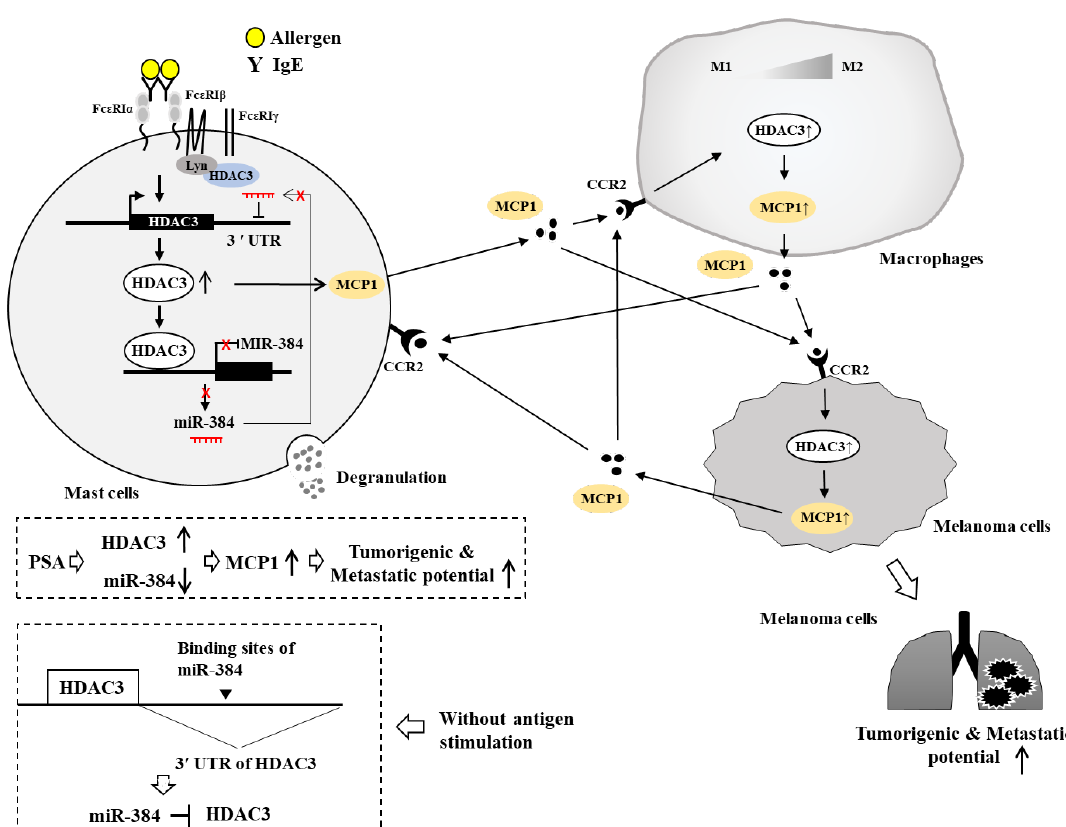
Figure 4. HDAC3-miR-384 negative feedback loop regulates PCA and PSA and cellular interactions during PCA and PSA. PSA increases the expression of HDAC3 and induces the activation of FcεRI signaling. HDAC3 binds to the promoter sequences of miR-384 to decrease the expression of miR-384. TargetScan predicts miR-384 as a negative regulator of HDAC3. In the absence of allergen stimulation, miR-384 binds to the 3 ′ UTR (untranslated region) of HDAC3 to decrease the expression of HDAC3. Thus, HDAC3 and miR-384 form a negative feedback loop. HDAC3 increases the expression of MCP1, which mediates cellular interactions and enhances the tumorigenic and metastatic potential of melanoma cells. MiR-384 negatively regulates PCA and PSA and the tumorigenic and metastatic potential of melanoma cells enhanced by PSA. Allergen-stimulated mast cells and melanoma cells promote a differentiation of M2 macrophages (TAM). M2 macrophages display a higher expression of CD163, but lower expressions of inducible nitric oxide synthase (iNOS) than M1 macrophages. Allergen-activated macrophages (M2) also activate mast cells and melanoma cells. Cellular interactions in this study were investigated by co-culture experiments. The ↑ arrows denote increased expression level/ increased characteristics and ↓ arrows denote decreased expression level. Hollow arrows denote positive regulation and T-bar arrows denote negative regulation. MCP1, Monocyte chemoattractant protein-1; HDAC3, Histone deacetylase 3; CCR2, c-c chemokine receptor type 2; PSA, Passive systemic anaphylaxis.